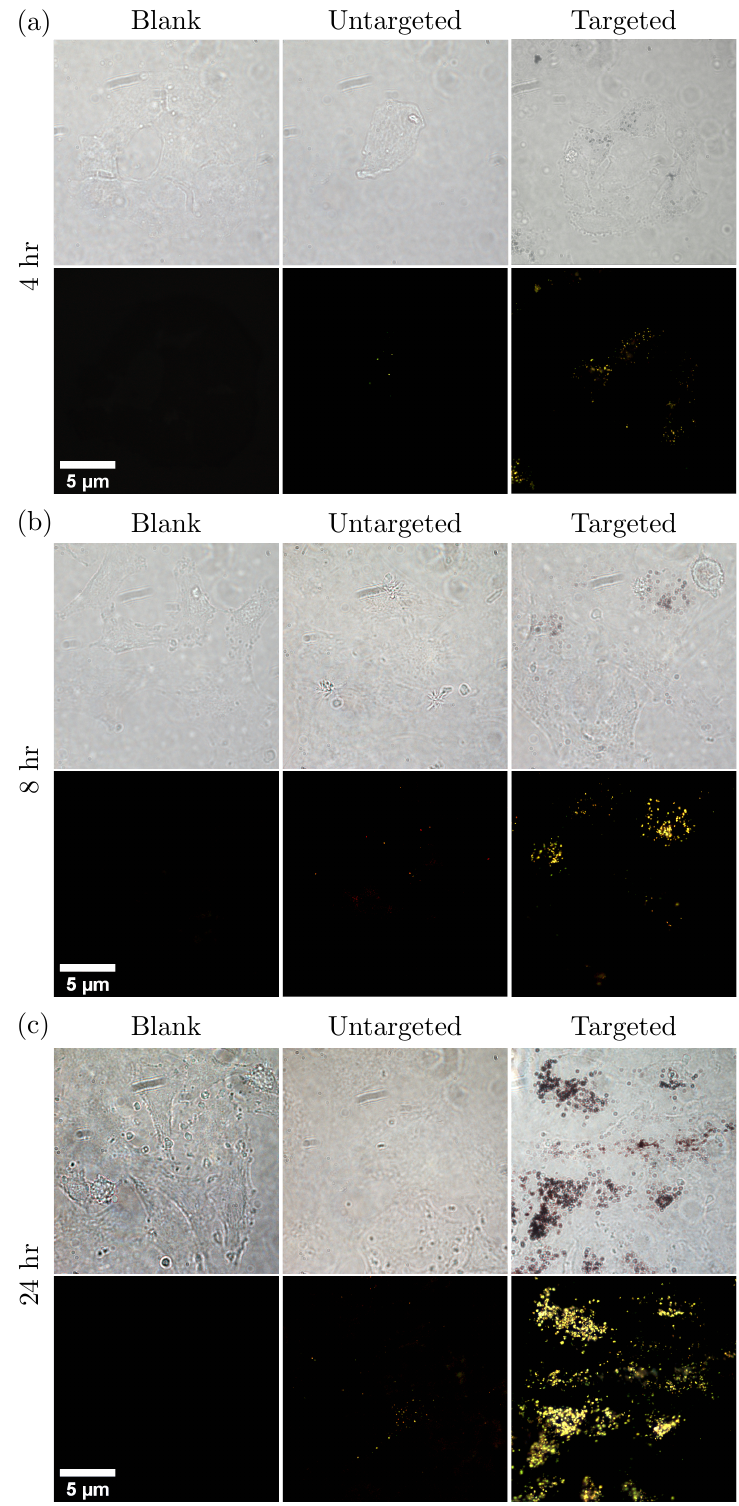
Figure 4. Bright- and dark-field images of lung cancer cells (A549) incubated with untargeted versus targeted (10µL antibody) S-Au40-849s for ( a ) 4h, ( b ) 8h, and ( c )